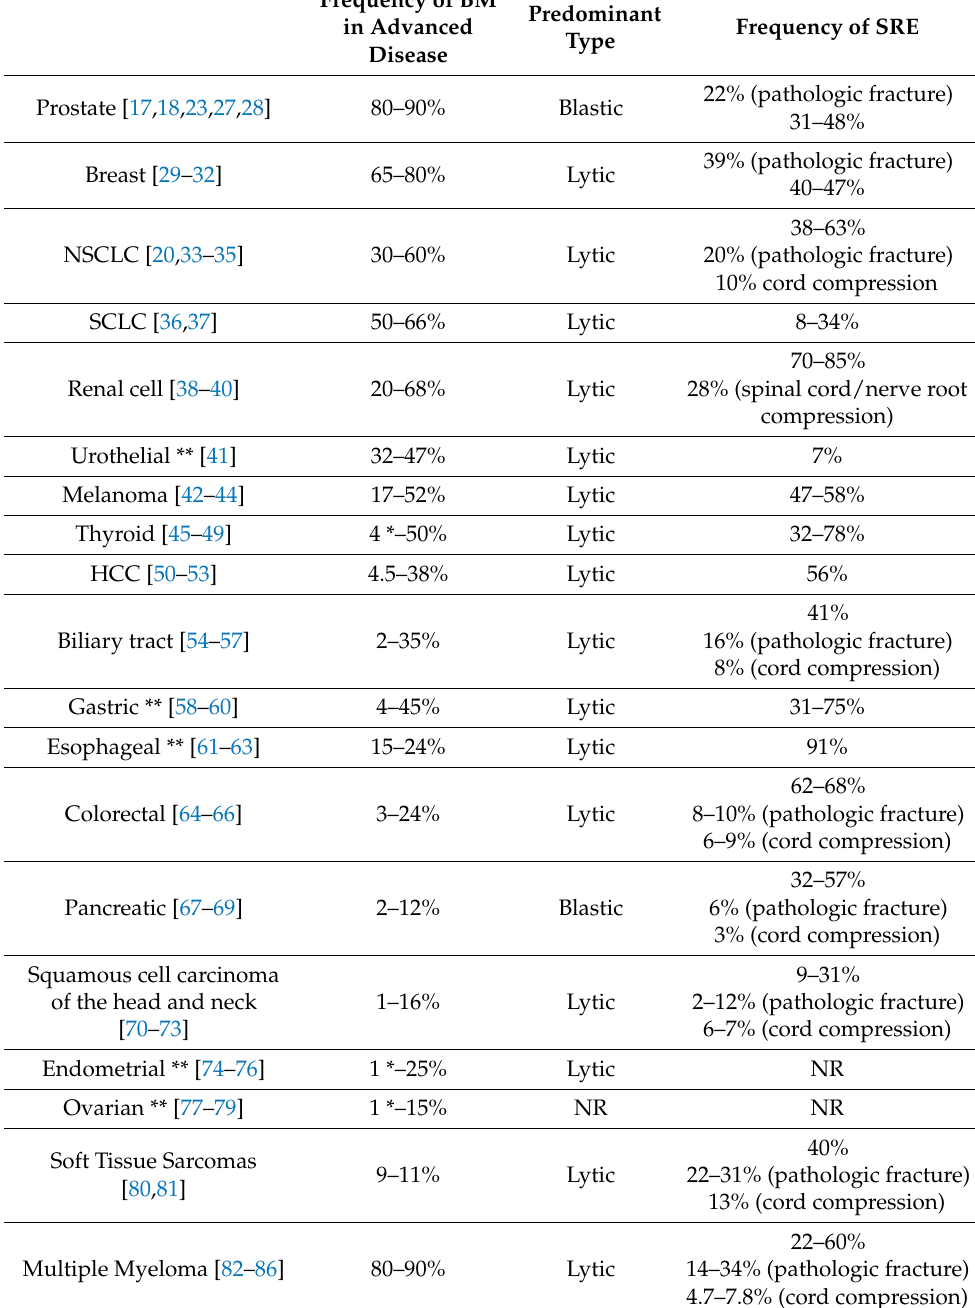
Table 1. Characteristics of bone metastases in diverse solid tumors. BM = bone metastases, SRE = skeletal related event, NSCLC = non-small cell lung cancer, SCLC = small cell lung can- cer, HCC hepatocellular carcinoma, NR not reported. * indicates frequency including all stages of that malignancy if frequency in advanced/metastatic disease was not specifically reported. ** indicates inclusion of data reported from autopsy series. SRE frequency was reported as the number of patients who experienced an SRE as a percentage of patients with clinically detected bone metastases. Frequency of BM in Advanced Disease